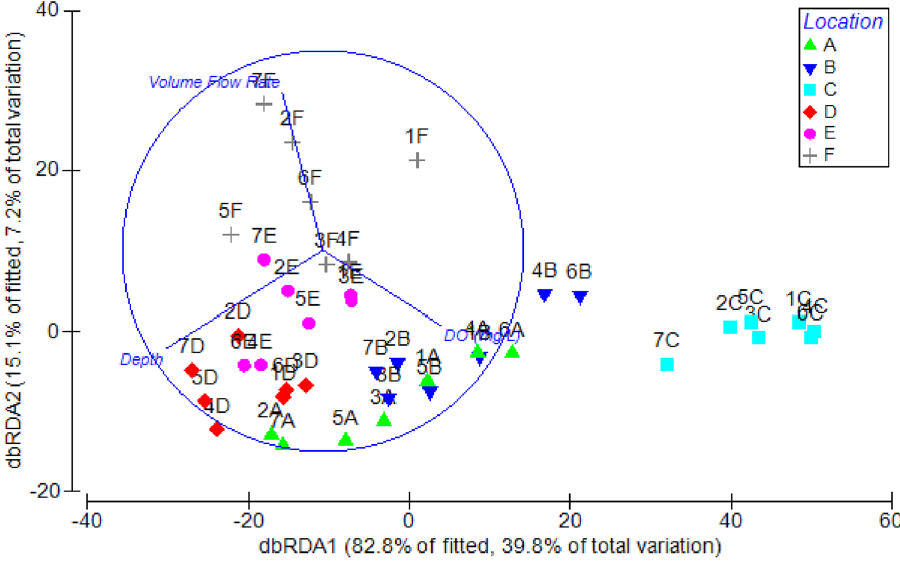
Figure 4. Ordination of the samples based on dbRDA scores of Distance-based Linear Model (DistLM) between physico-chemical parameters (see Table 2) among the six sampling sites (sites F–E–D are located above the weir and sites C–B–A are located below the weir, see Fig.